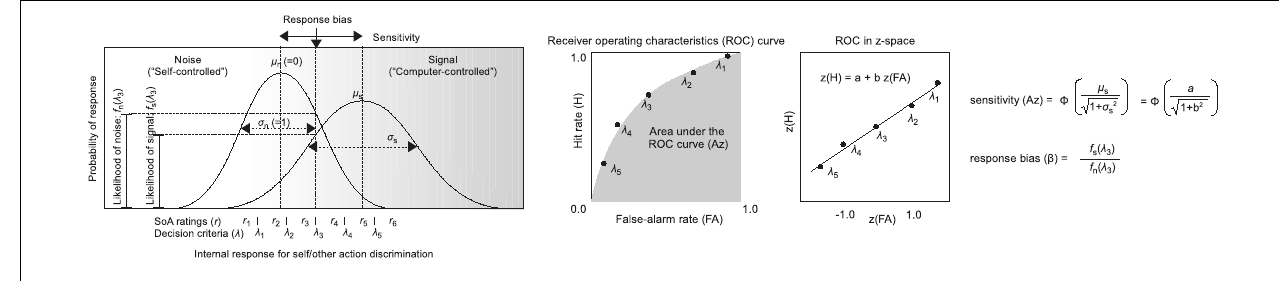
FIGURE 3 | Graphical explanation of the application of the signal detection theory (SDT) to the agency judgment (AJ) data with sense of agency (SoA) ratings, assuming that the variance is unequal between the noise and the signal.